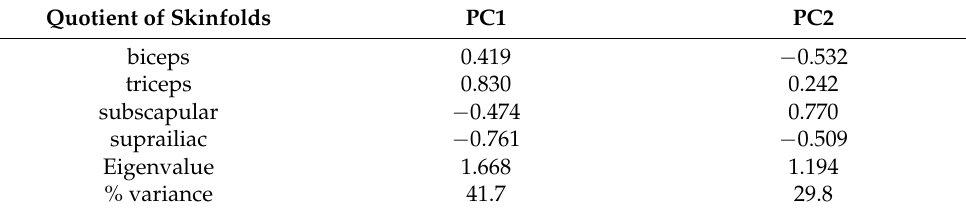
Table 2. Results of principal components analysis of the four skinfold